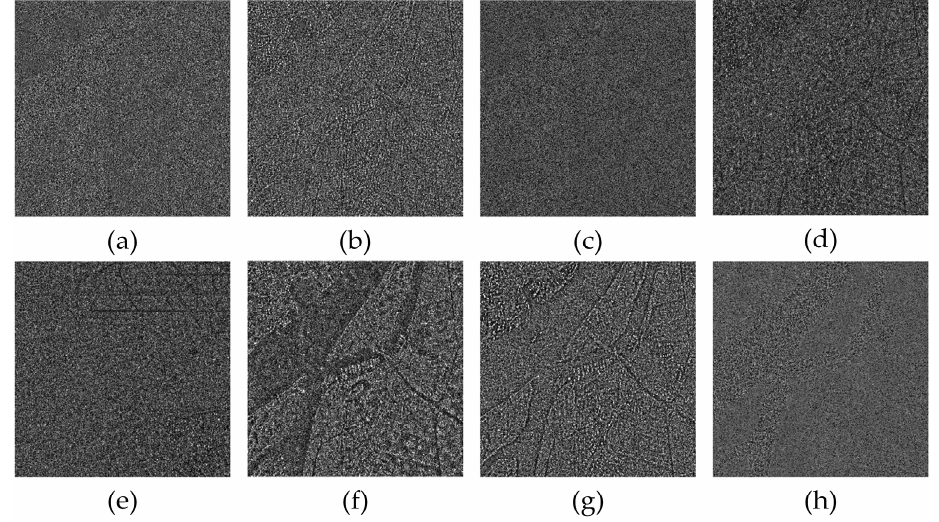
Figure 13. Ratio images between noisy and filtered RadarSAT-2 SAR images using ( a ) DPAD, ( b ) EnLee, ( c ) SAR-BM3-D, ( d ) FANS, ( e ) PPB, ( f ) DnCNN, ( g ) NL-means, and ( h ) MDLPIA-NLM fil- ters.